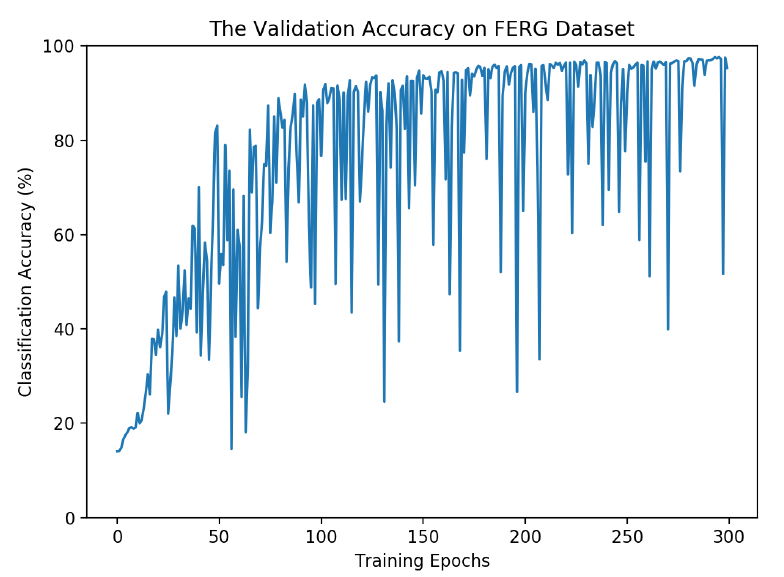
Figure 14. The validation accuracy over different epochs for the model trained on the FERG